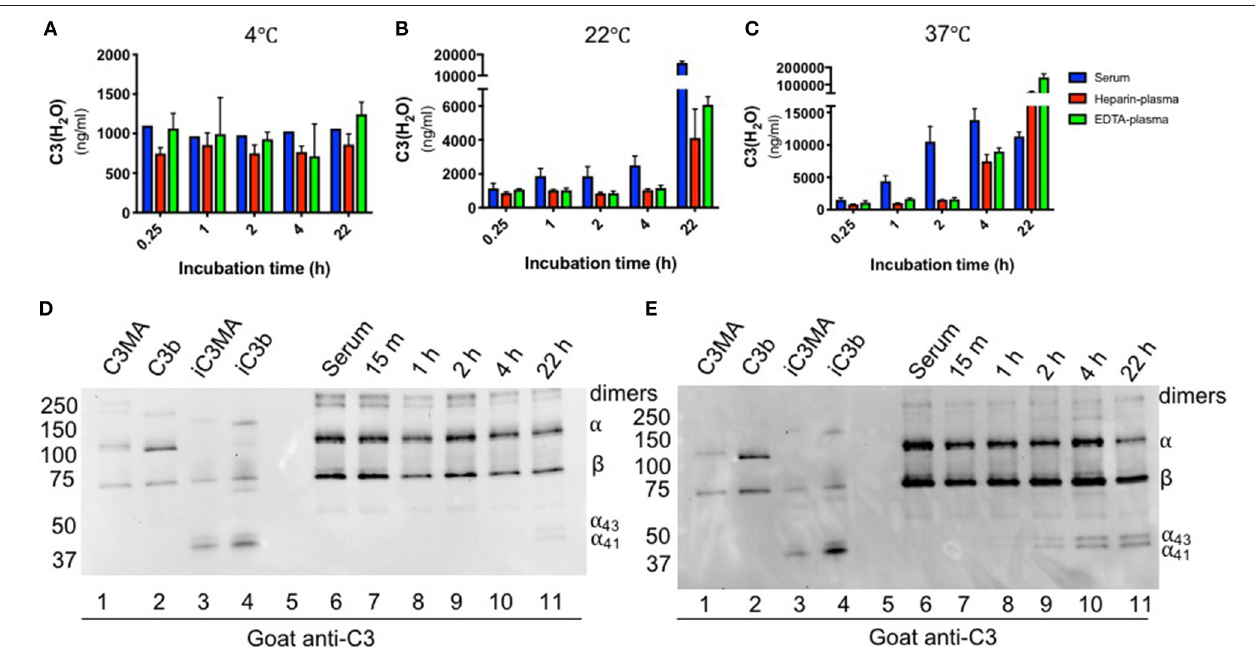
FIGURE 4 | Effect of time and temperature on C3(H 2 O) generation in serum and plasma. Samples were incubated for the indicated time at 4 ◦ C (A) , 22 ◦ C (B) or 37 ◦ C (C) and then stored at − 80 ◦ C prior to analysis; n = 3 healthy donors. C3(H 2 O) generation (i.e., tickover) does not occur up to 22h at 4 ◦ C, occurs minimally over 4h at RT, but occurs more rapidly (particularly in serum) at 37 ◦ C. Serum samples incubated at RT (D) or 37 ◦ C (E) were diluted 1:500 and assessed for C3 breakdown by WB under reducing conditions with a goat anti-C3 pAb. Note that we routinely detect low level contamination of C3 dimers in all purified C3 preps and sera samples that we evaluate by WB. Dimers are indicated in